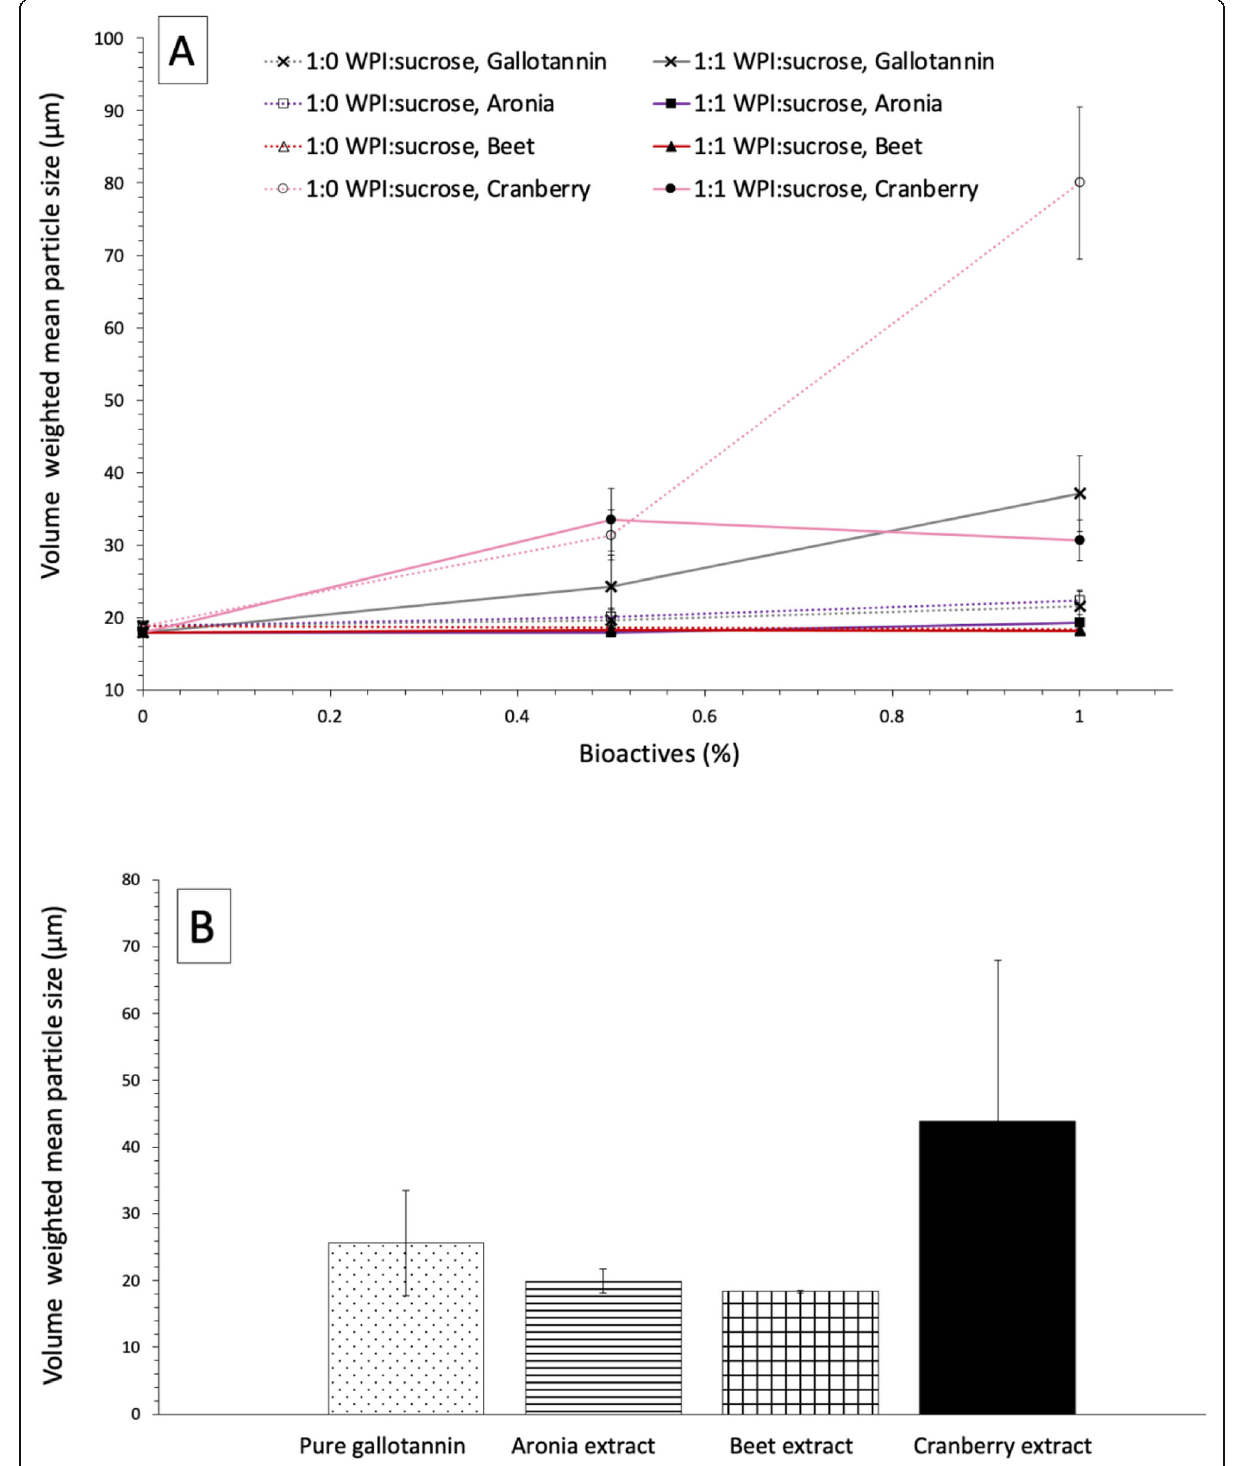
Fig. 3 Effect of bioactives content (%) A on the average particle sizes ( μ m) of dispersions at 25 °C; the effect of bioactives source B on the average particle sizes ( μ m) of all dispersions comprised of pure gallotannin, Aronia berry, beet, and cranberry extracts, respectively, at 25 °C; ( n = 9). Lines are for guiding purposes only